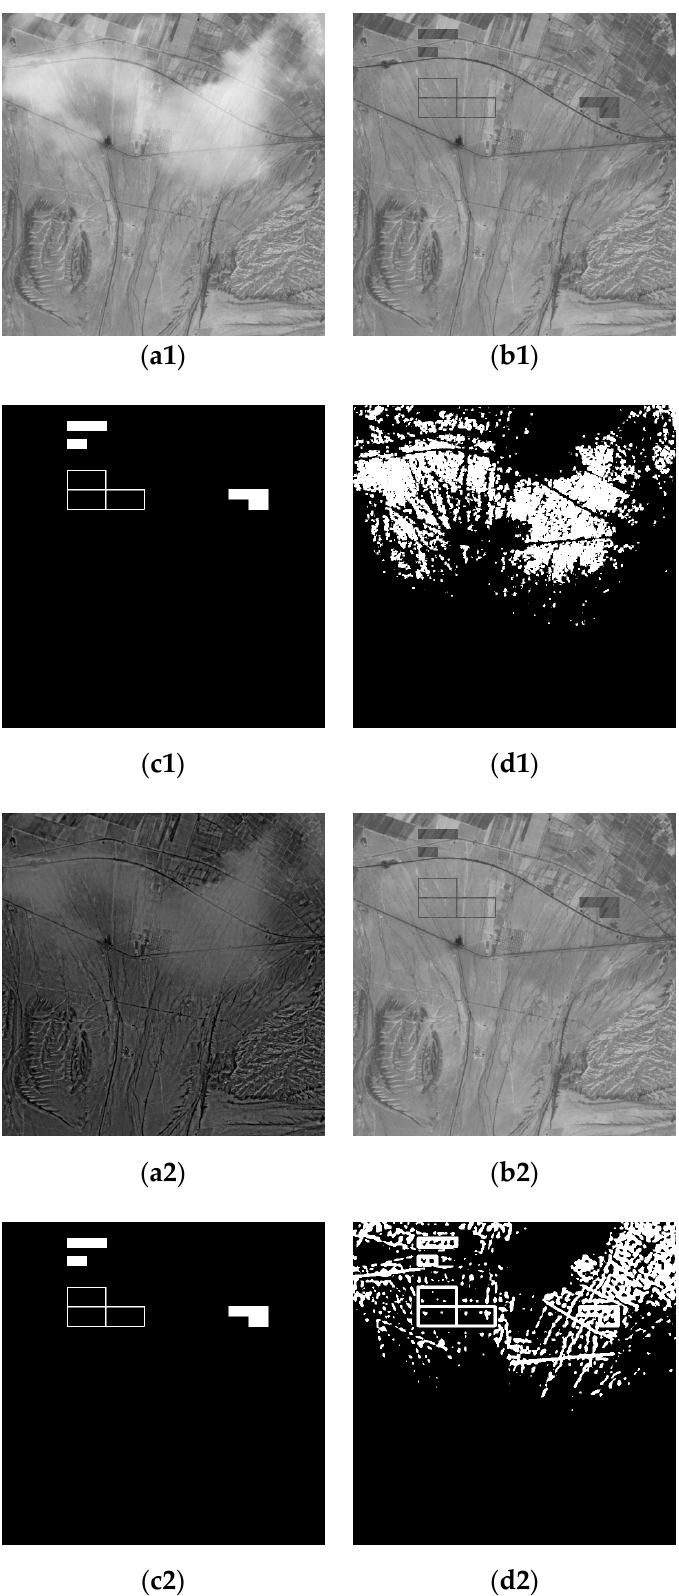
Figure 7. Comparison of changes before and after thin cloud: ( a1 ) before removing thin cloud (phase one); ( a2 ) after removing thin cloud (phase one); ( b1 ), ( b2 ) phase two; ( c1 ), ( c2 ) reference; ( d1 ) the results before removing thin clouds; ( d2 ) the results after removing thin clouds.